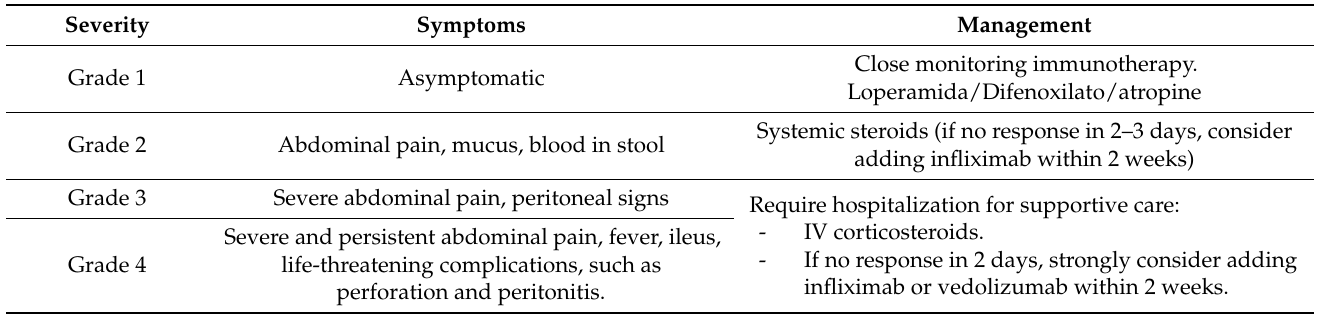
Table 3. Symptoms and management of colitis according to grade. Table adapted from Som A. et al.